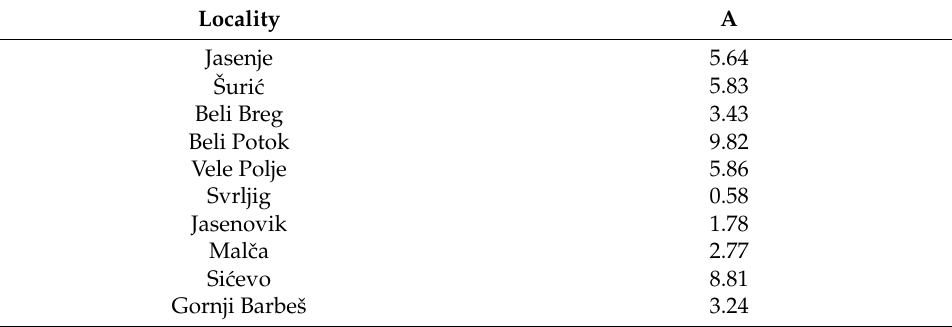
Figure 7 . Mean annual soil loss in the Niš region (t ha −1 y −1 ) Figure 7. Mean annual soil loss in the Niš region (t ha Table 4. Mean annual soil loss in observed